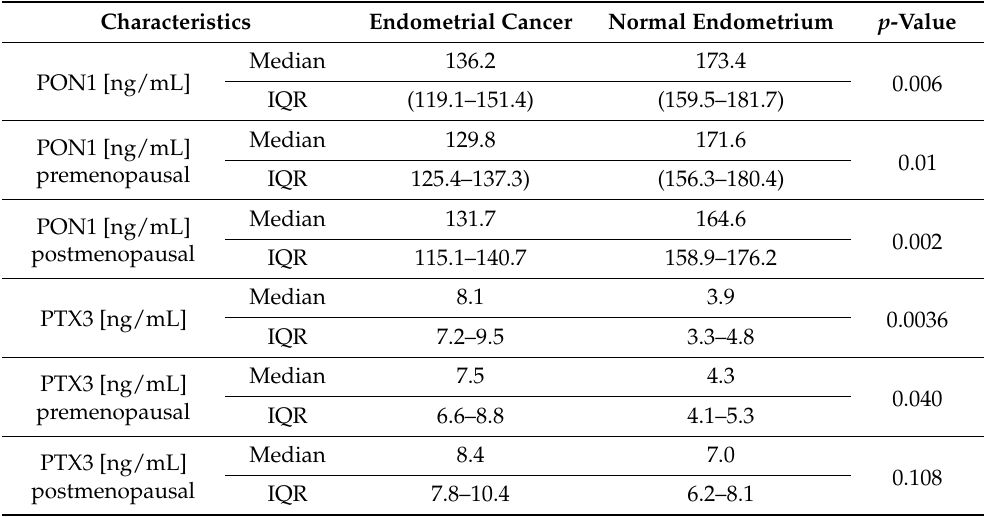
Table 3. Comparison of PON1 and PTX3 levels between patients with endometrial carcinoma and the control group.